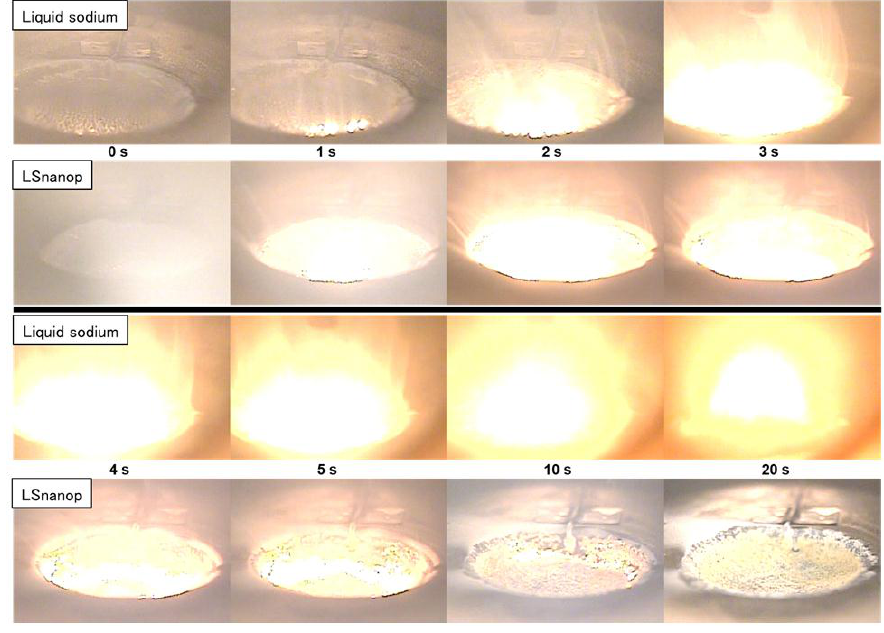
Figure 10. A comparison of reaction to oxygen between the LSnanop and liquid